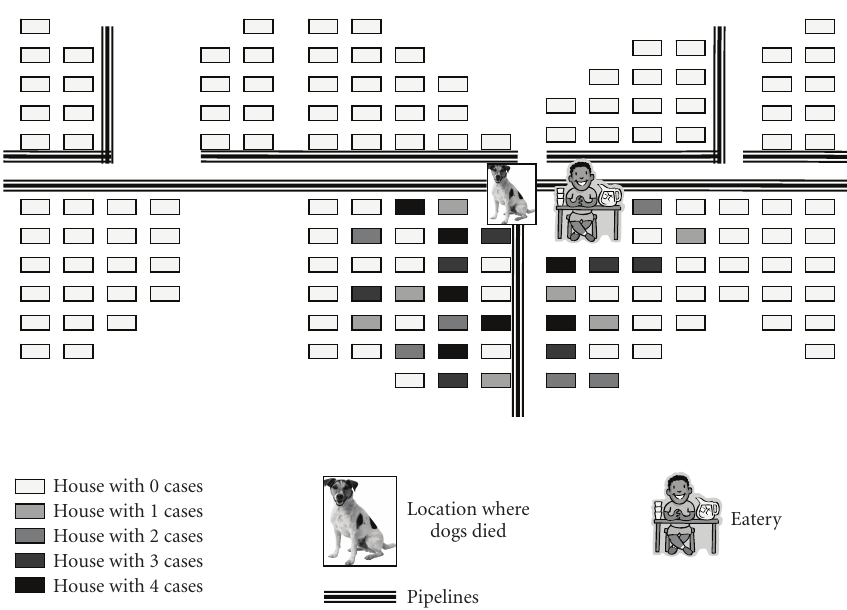
Figure 2: Organophosphorous poisoning cases in Sindhikela, Bolangir, Orissa, India, 2008.